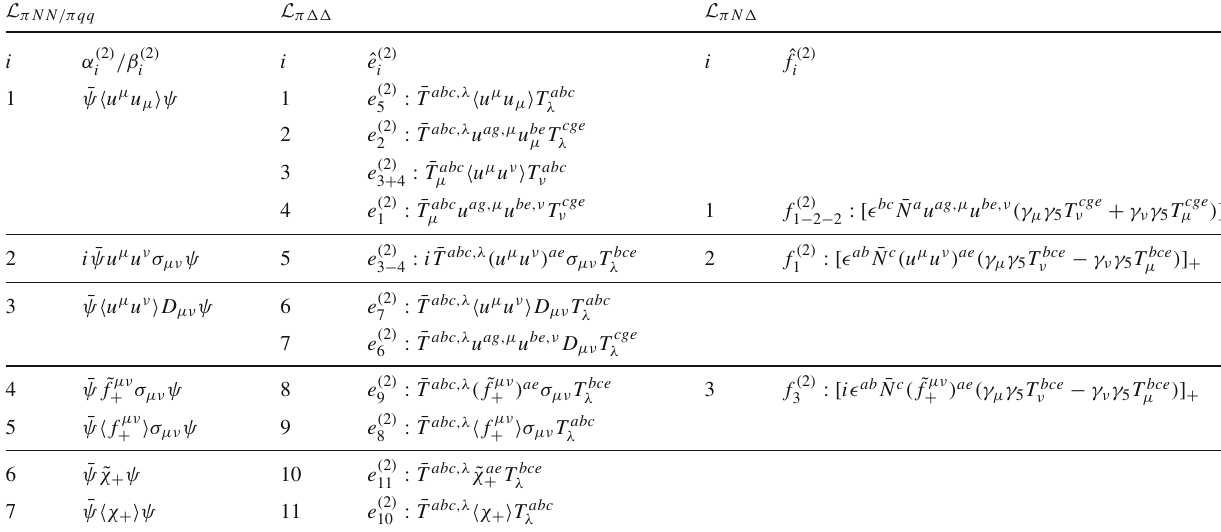
tolabelthe interactionterms and α coupling constants, respectively. The meaning of symbols like f is explained in the